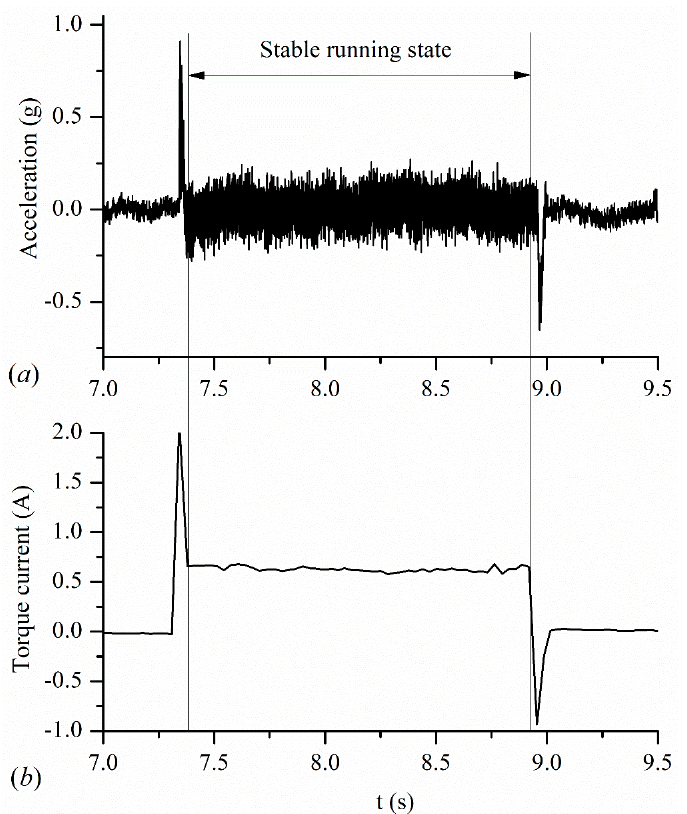
Figure 26. Acceleration signal and torque current of servo motor (TCSM) signal. ( a ) Acceleration signal. ( b ) TCSM signal.